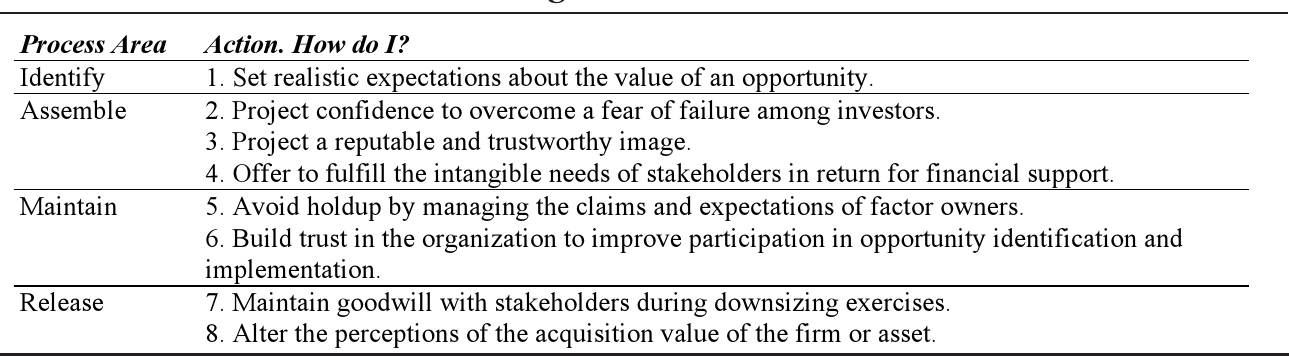
Table 1. Targeted Areas for Action